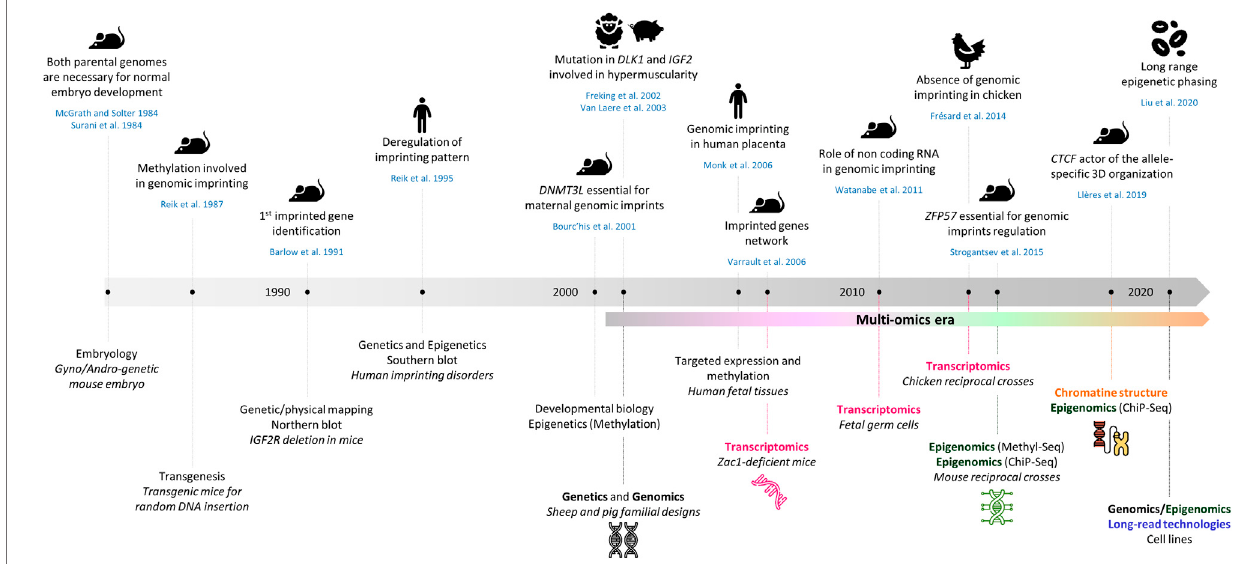
FIGURE 1 | Comparative timeline of key discoveries in genomic imprinting and novel high-throughput sequencing technologies. The references cited in the fi gure are also present in the text unless they are mentioned hereafter (Surani et al., 1984; Watanabe et al., 2011; Strogantsev et al., 2015).